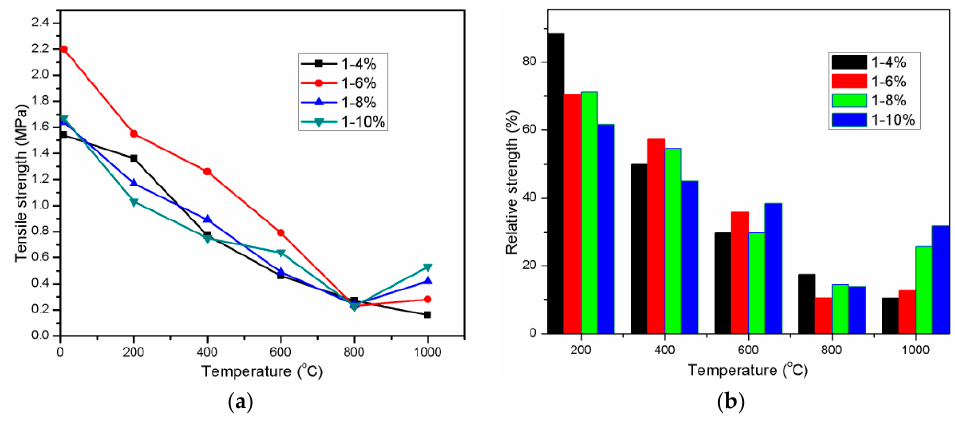
Figure 7. Residual tensile strength ( a ) and relative tensile strength ( b ) of AAS mortar.